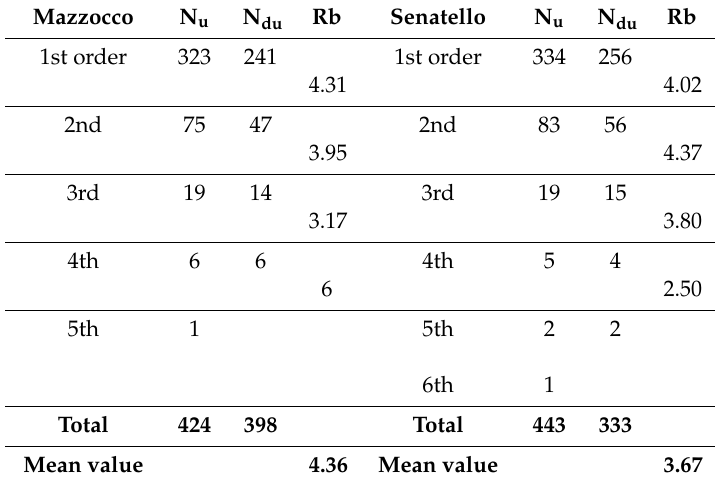
Table 2. Nu, Ndu and Rb values counts for Mazzocco and Senatello river